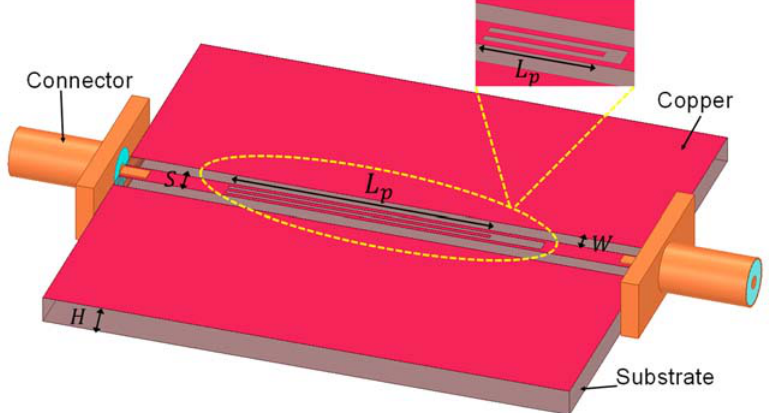
Figure 1. Schematic diagram of the proposed ungrounded coplanar waveguide (UGCPW) embedded resonator.